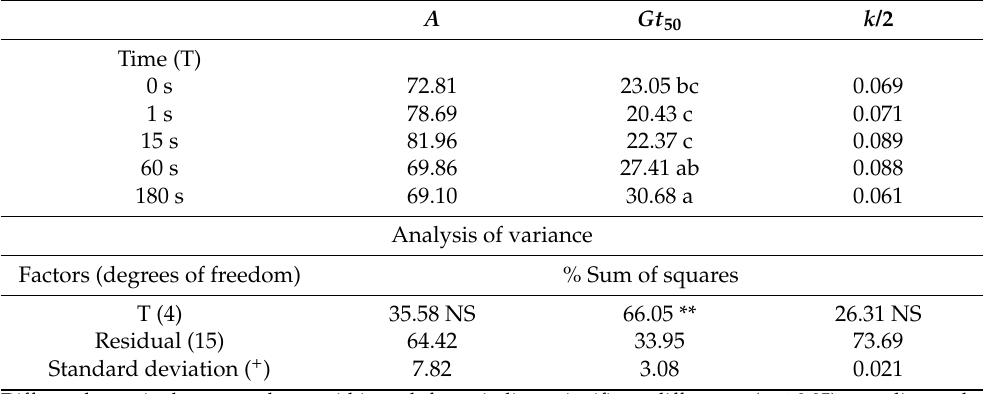
Different letters in the same column within each factor indicate significant differences ( p ≤ 0.05) according to the LSD test. **: significance level p ≤ 0.01; NS: Not significant. ( + ) The standard deviation has been calculated as the square root of the residual mean